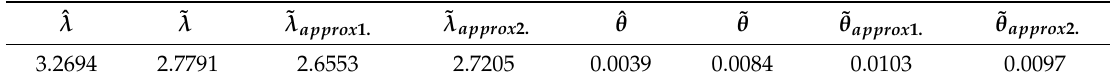
Table 3. Estimates of λ and θ for the observed progressive Type-II censored